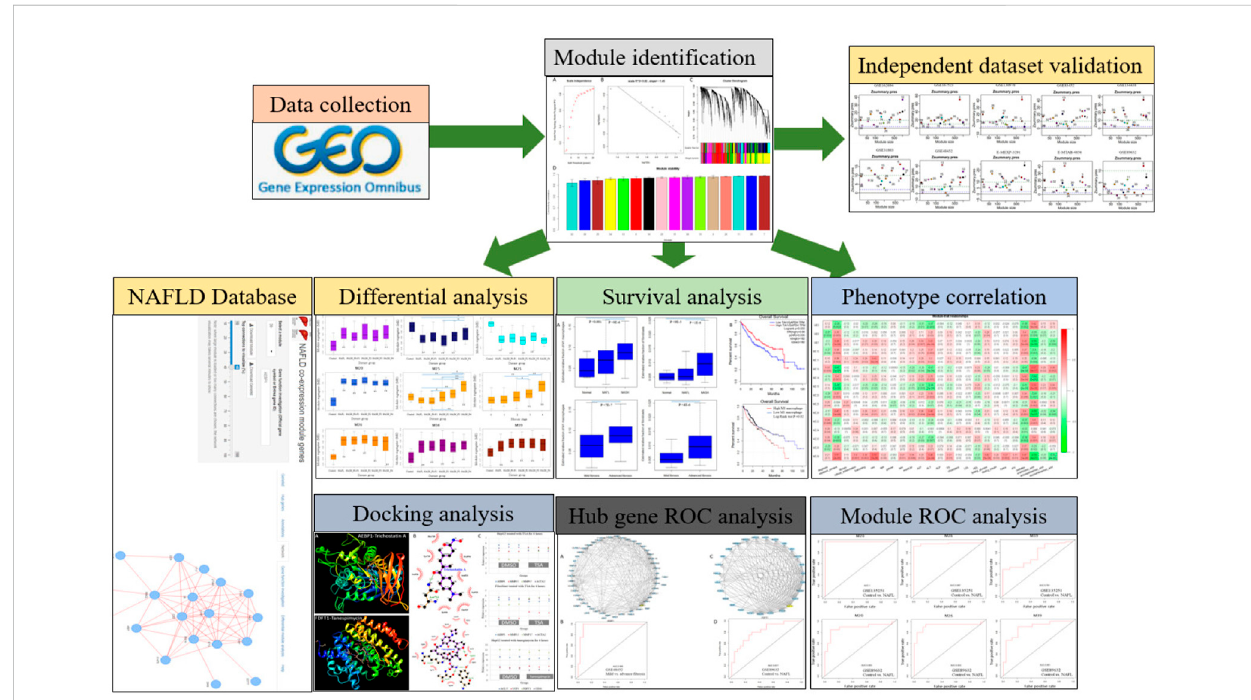
FIGURE 1 A schematic diagram for the analysis framework. NAFLD transcriptome datasets were collected and analyzed by gene co-expression network analysis. Independent datasets were used for network validation. Based on the identi fi ed network modules, the NAFLD database was constructed. Module-leveldifferentialanalysis,ROC analysis,andphenotype correlationwereperformed.Modulehubgeneswereminedforpotential drugdiscovery.